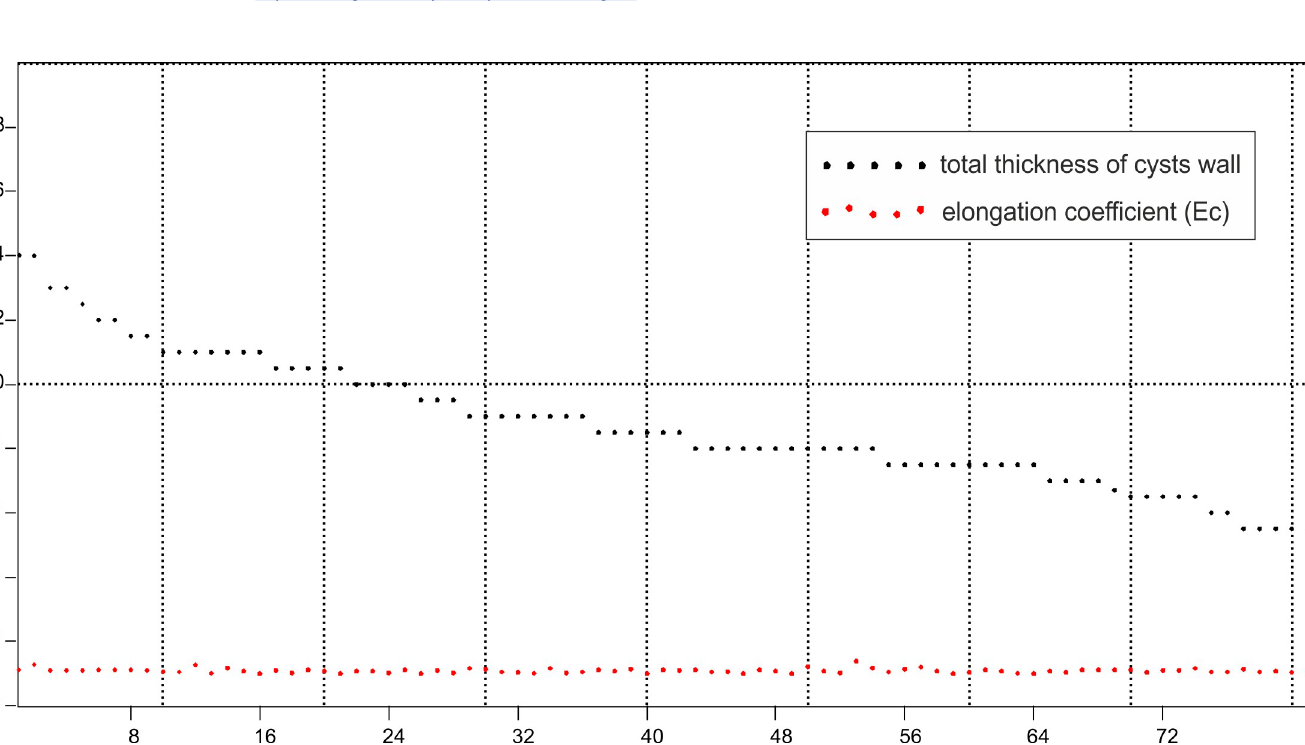
Fig 10. Diagram representing the relation between the total thickness of cysts wall and elongation coefficient (Ec = L/W) of Cadosinopsis rehakovii sp. nov.